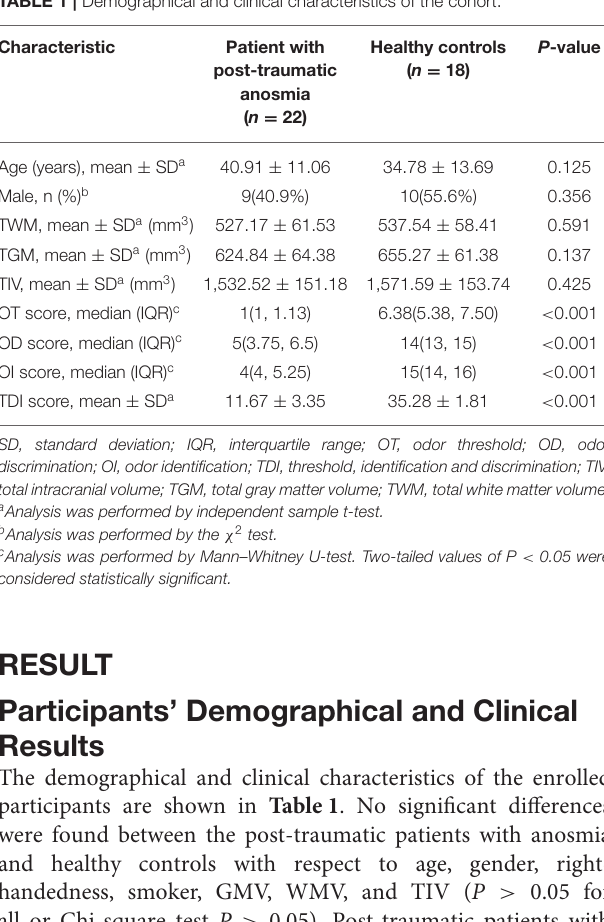
TABLE 1 | Demographical and clinical characteristics of the